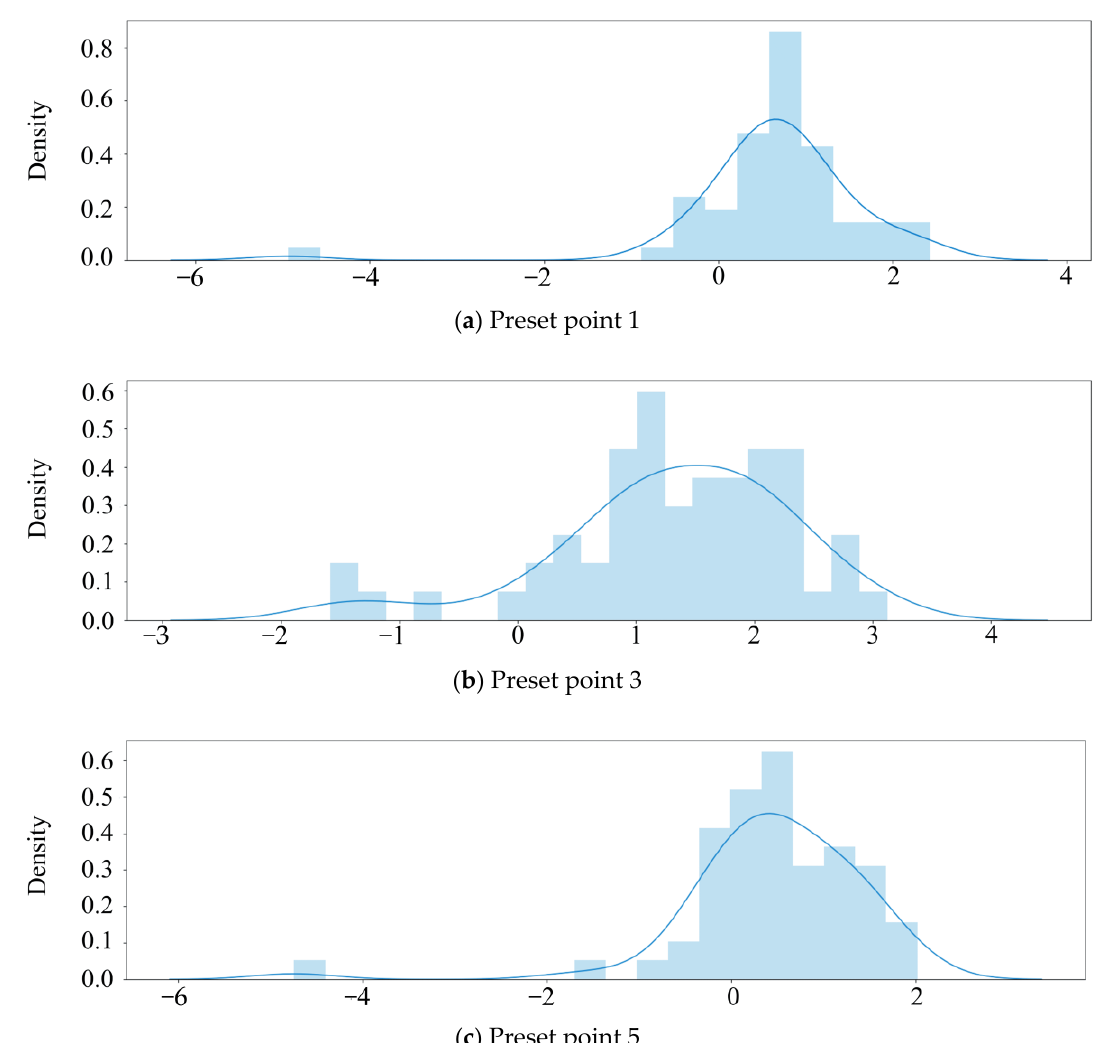
Figure 7. Data distribution plot of the GRU model.